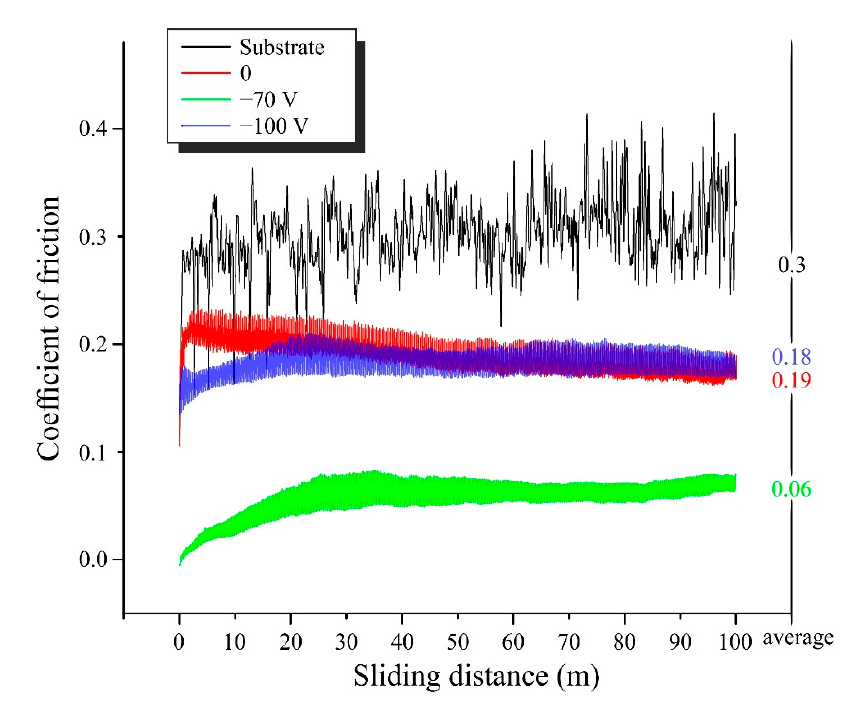
Figure 4. CoF for titanium V Т 6 substrate and TiCN coatings obtained at U s = 0, − 70, − 100 V. Tribological tests showed reduced wear in TiCN coatings obtained with substrate bias compared to without voltage coatings. Figure 5 shows the average CoF and wear rate (WR) for the VT6 substrate and TiCN coatings obtained at U s = 0, − 70, and − 100 V. The TiCN coatings deposited without voltage and at − 100 V showed more similar CoF, but the WR differ significantly for them. The WR of the − 100 V sample is almost two times lower than the WR of the sample without voltage. The best results among the obtained coatings were achieved by the coating deposited at − 70 V with WR equal to 1.4 × 10 − 6 mm 3 /mN. This is due to the higher hardness, higher sp 2 carbon content, and higher proportion of phase composition TiCN, which is consistent with the results of works [9,25]. The coatings wore approximately close to each other despite the significant difference in the average CoF values for − 70 and − 100 V. The − 70 V sample showed a strong decrease in CoF, which was certainly due to the higher carbon content in its structure (34.4 at %), which promotes the growth of amorphous intergrain phases [17]. All obtained coatings show low CoF without sharp jumps in the graph, which indicates a high cohesive and adhesive strength of the formed coatings by the MS method [31].